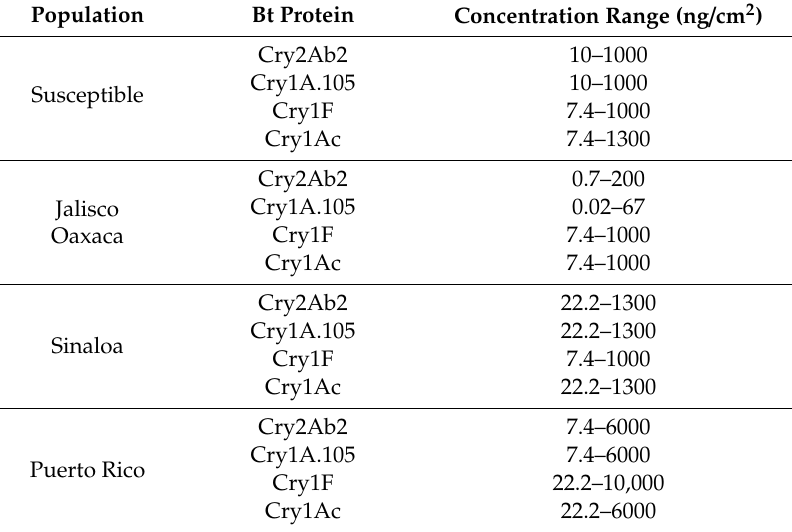
Table 1. Bacillus thuringiensis (Bt) protein concentrations used in concentration–mortality response bioassays. Population Bt Protein Concentration Range (ng / cm 2 )